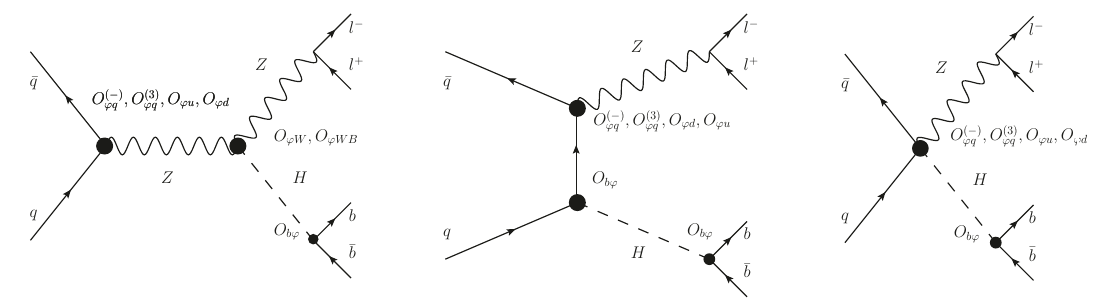
Figure 6. Same as figure 2 for Higgs associated production with a Z -boson, hZ → b ¯ b‘ + ‘ − ,